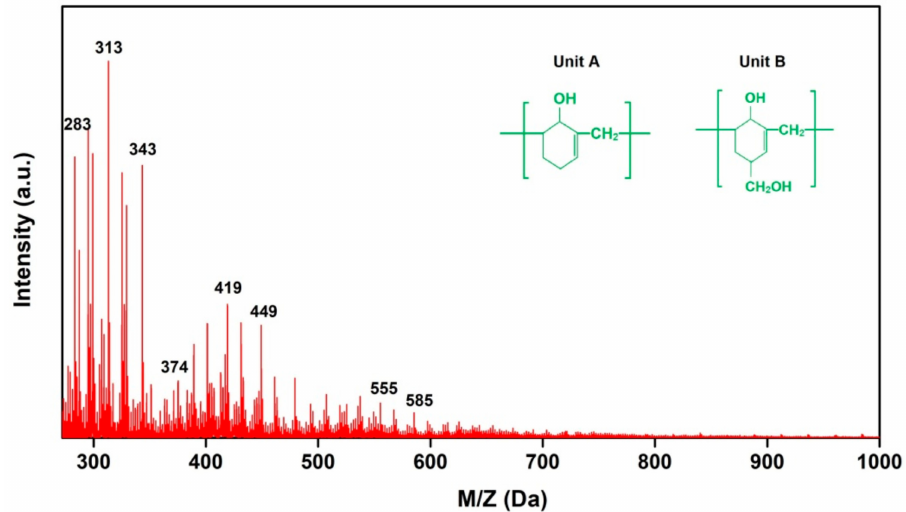
Figure 3. The MALDI-TOF spectra of phenol formaldehyde (PF)